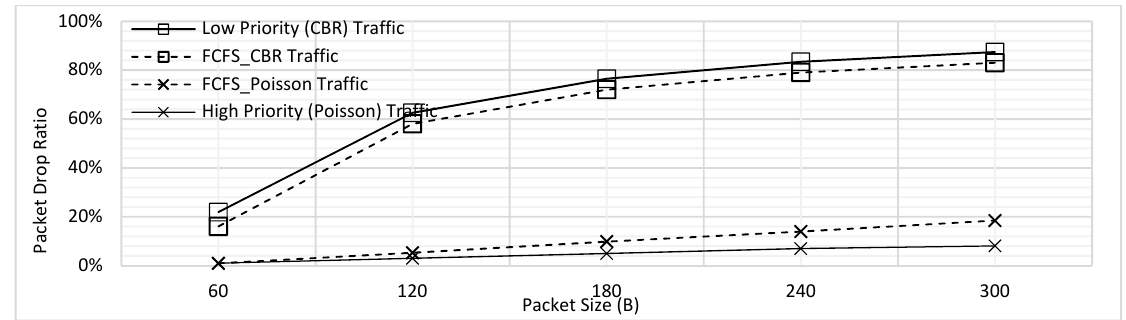
Figure 9. PDR Comparison for with and without Prioritization (Figures 4 and 6 Combined).